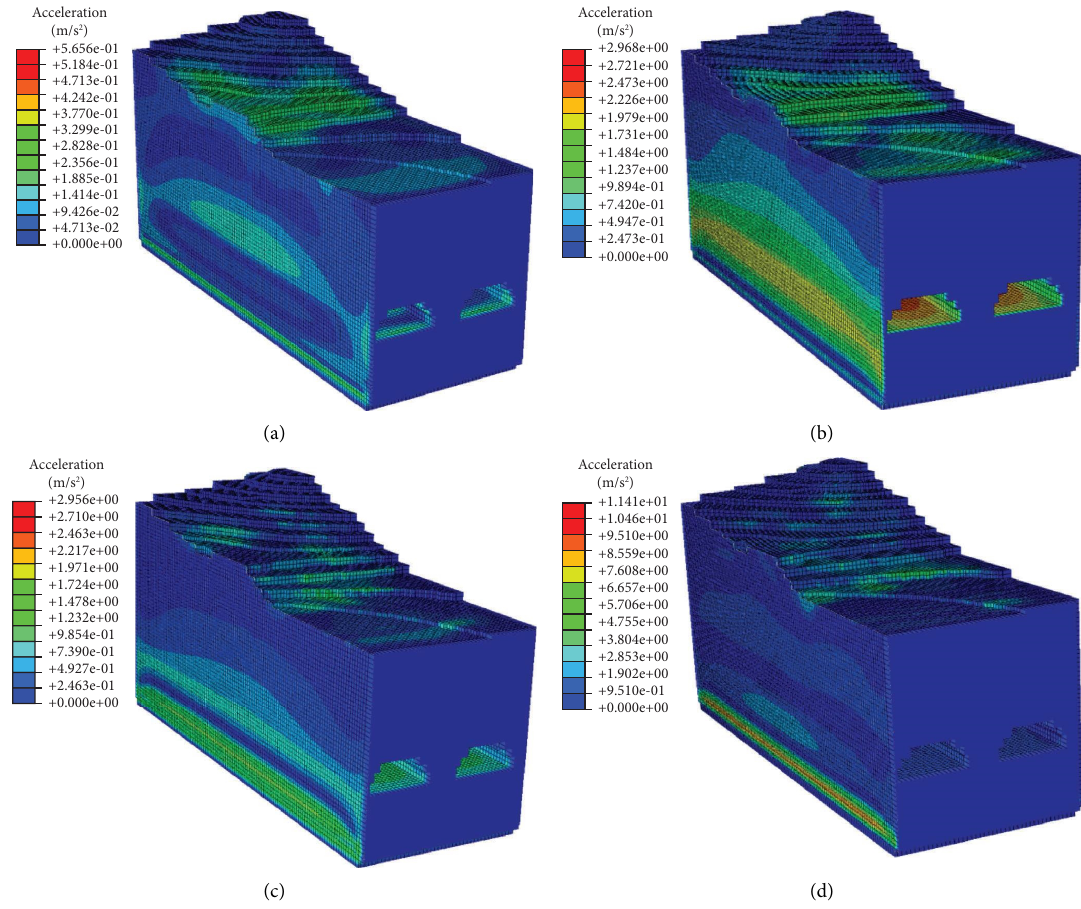
Figure 13: Acceleration responses under diferent seismic intensities: (a) VI. (b) VIII. (c) IX. (d) > IX. Table 4: Maximum Mises stress and strain of tunnel under diferent seismic intensities. Seismic